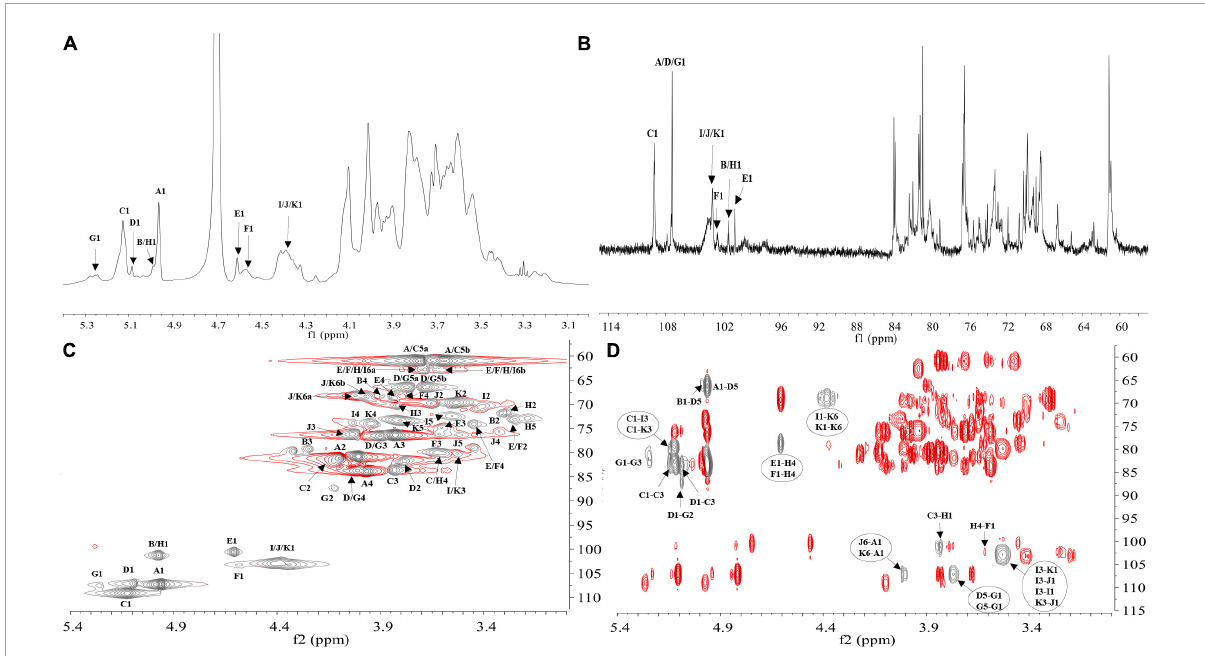
FIGURE3 NMR spectra recorded for LFP-80-W1 (600 MHz): (A) 1 H NMR spectrum; anomeric hydrogen signals are annotated. (B) 13 C NMR spectrum; anomeric carbon signals are annotated. (C) HSQC spectrum. The most relevant correlations are annotated and marked in gray. A1 represents the cross-peak between H-1 and C-1 of residues A; B1 represents the cross-peak between H-1 and C-1 of residues B and so on. (D) HMBC spectrum. The most relevant correlations are annotated and marked in gray. A1-D5 represents the cross-peak between H-1 of residues A and C-5 of residues D; J6-A1 represents the cross-peak between H-6 residues J and C-1 of residues A and so on. (Glycosylated residues A-K are summarized in Table 2 ).